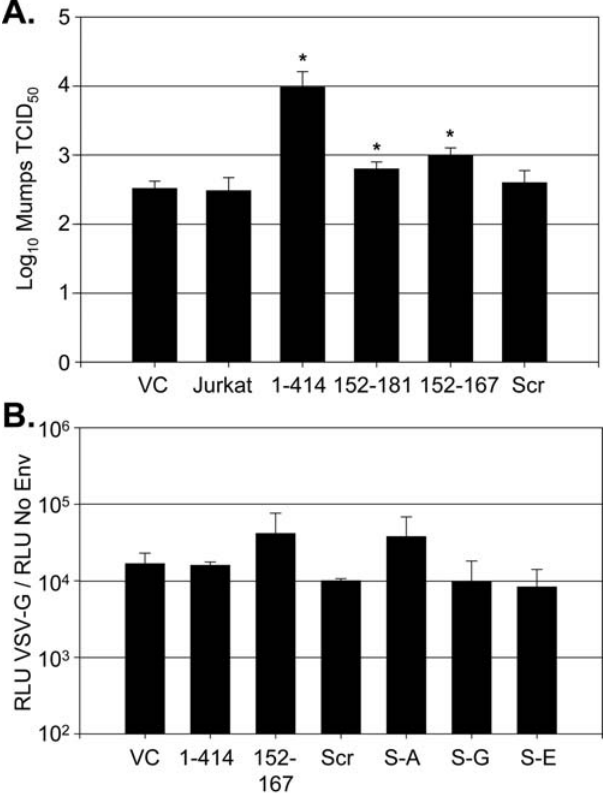
Figure 5. The inhibitory effect of NS5A expression is specific for HIV replication. The infectious titer of mumps virus was not inhibited in Jurkat cells expressing full-length GBV-C NS5A (1–414) or the 152–181 NS5A peptide compared to the vector control (VC) or parent Jurkat cells (A). Mumps virus replication was increased in Jurkat cells expressing full-length NS5A (*; p=0.029). Similarly, panel B demonstrates that VSV-G pseudotyped retroviruses transduced all NS5A and control cell lines with similar efficiency as measured by relative luciferase activity in VSV-G pseudotype particles relative to the no-envelope control particles (p . 0.05 for all compared to VC). 152– 167=cells expressing this NS5A 16mer peptide, Scr=cells expressing scrambled 16mer peptide, and S-A, S-G, S-E=cells expressing the S158A, S158G, and S158E substitutions.